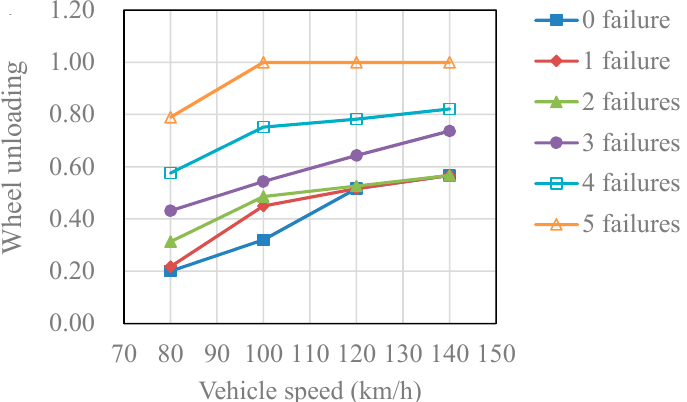
Figure 10. The wheel unloading ratio at different speeds and under different cases.